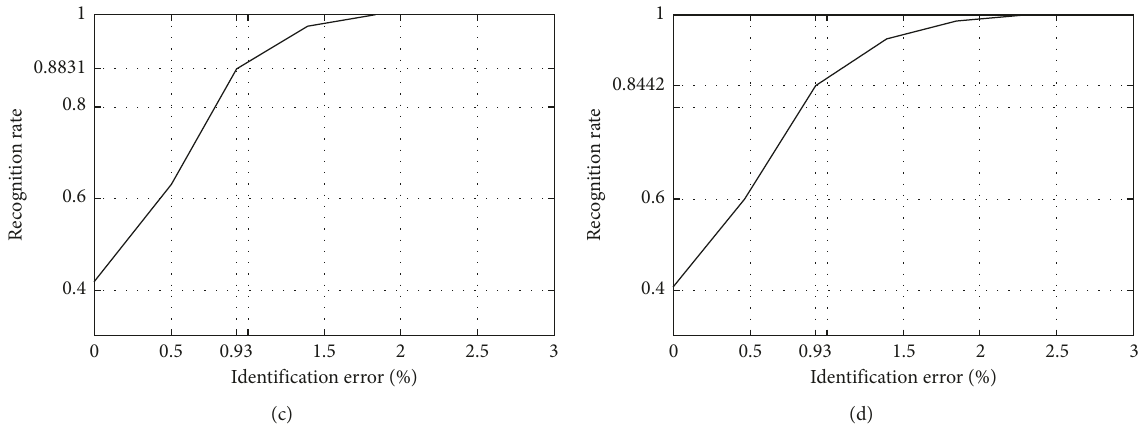
Figure 15: Fusion feature recognition rate of BP network different nodes: the hidden layer has (a) 11 nodes, (b) 12 nodes, (c) 15 nodes, and (d) 18 nodes.